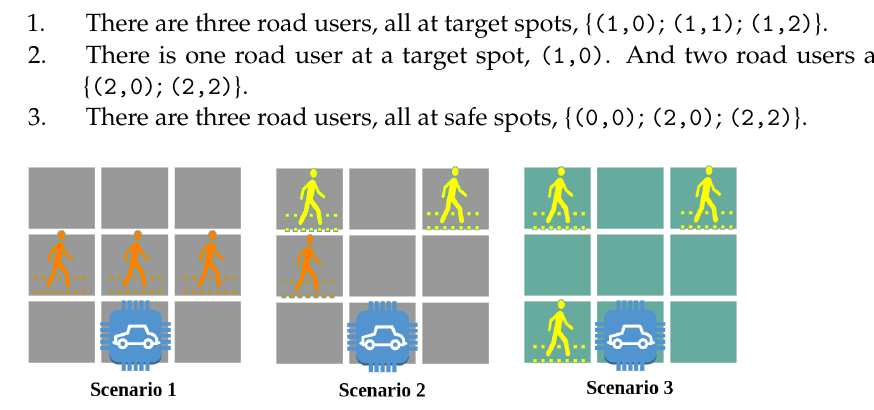
Figure 7. Three testing scenarios.